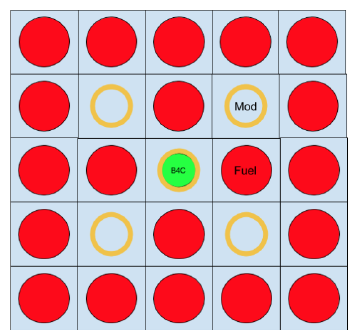
Figure 3: 5 × 5 Assembly Radial